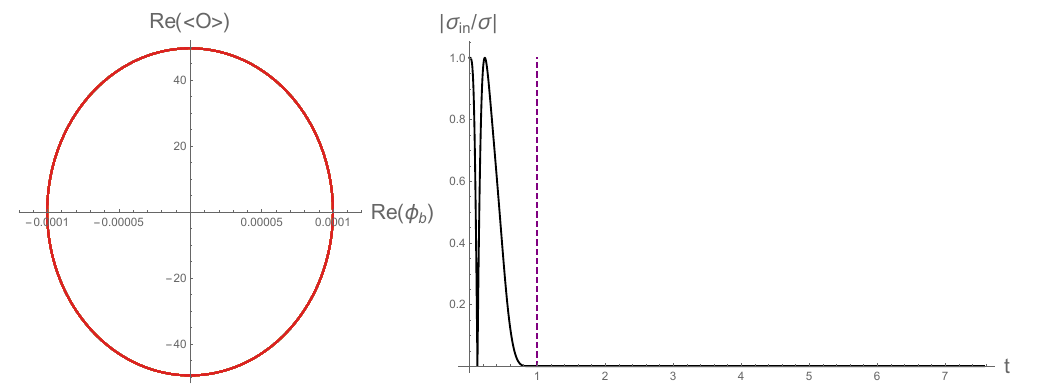
Figure 30 . Left: phase portrait of the late-time dynamics of a quench process of the form (3.1) with (cid:15) = 10 (cid:0) 4 ; ! b = 20 (cid:25) and (cid:12) = 1. We start at t = (cid:12) . The di(cid:11)erent periods of time evolution collapse into a single curve. Right: relative value of the imaginary part of the nonlinear conductivity (cid:27) . Its vanishing after the quench indicates that the response is in perfect phase opposition with the